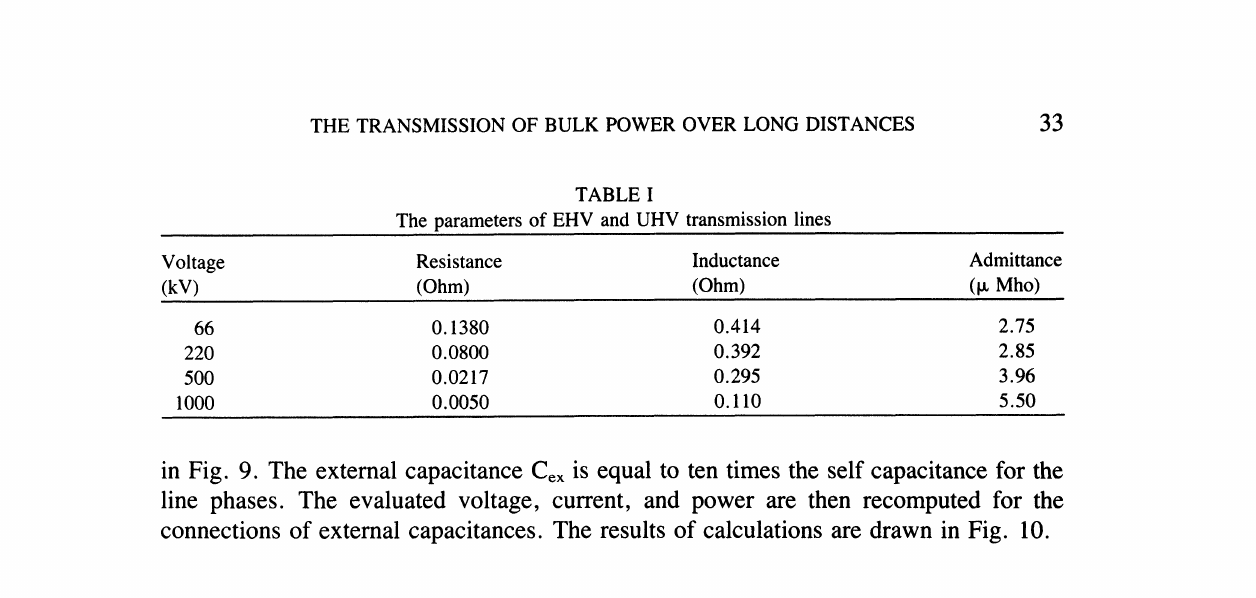
The parameters of EHV and UHV transmission lines